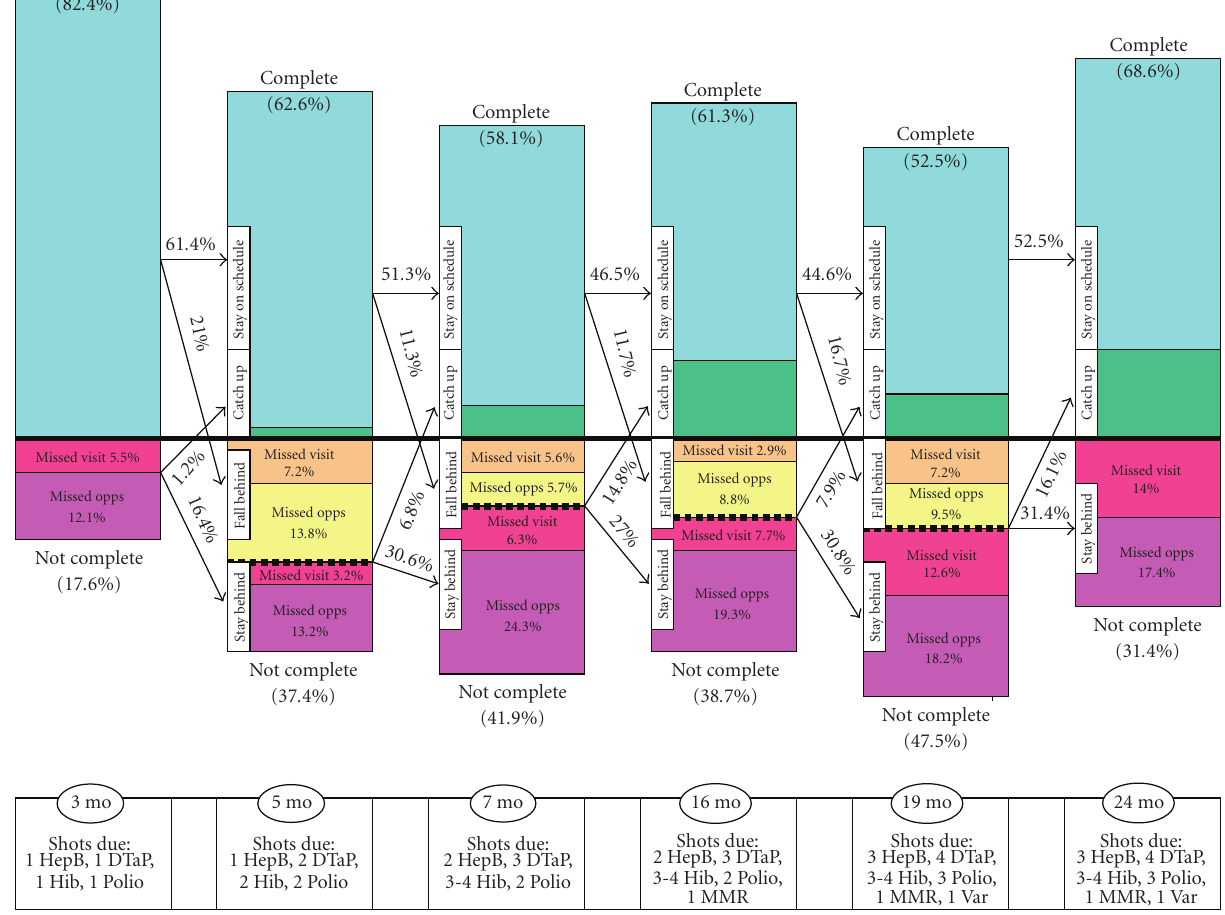
Figure 2: Immunization Completeness At Milestone Ages (for Two Year Olds in 2007, N =